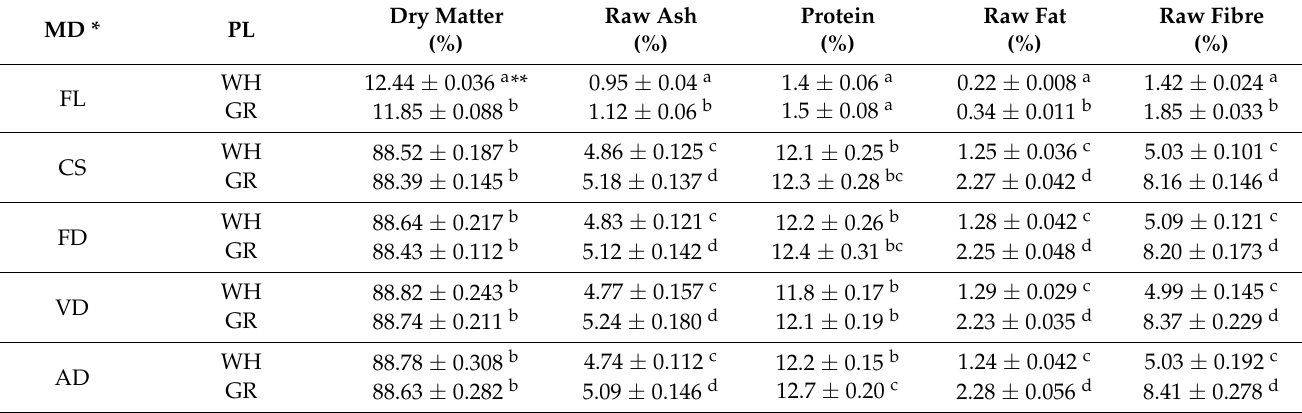
Table 2. Basic chemical composition of fresh and dried